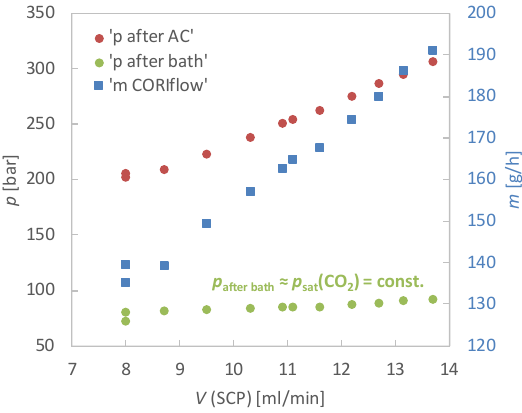
Fig. 6. Inlet pressure ( p after AC), outlet pressure ( p after bath) and mass flow rate through capillary tube CAP 4 ( d = 0.01 mm, L = 4.0 m) depending on flow rate set on the SCP pump.